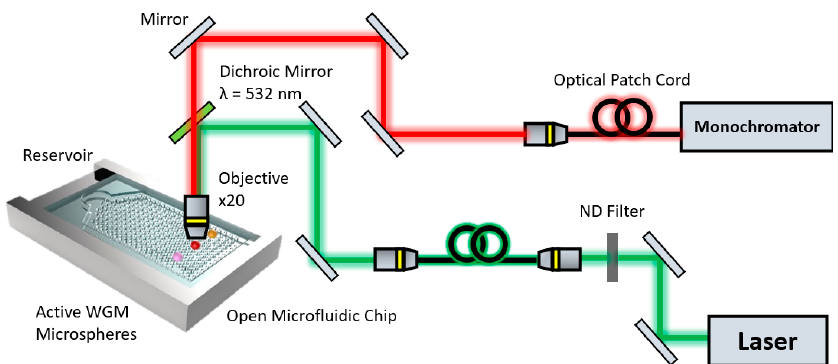
Figure 2. Experimental setup using inverted microscope for interrogation of whispering gallery microspheres integrated into the open microfluidic chip.